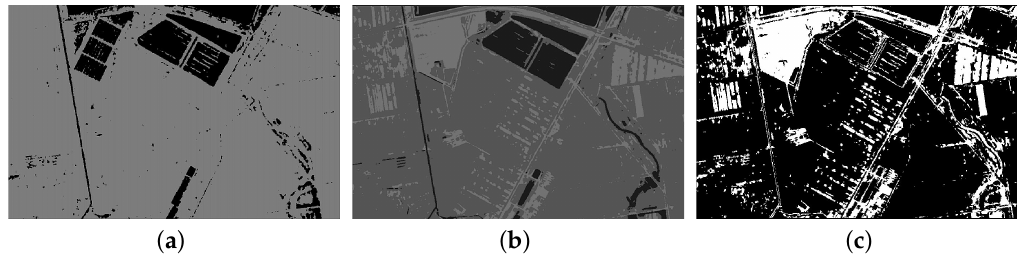
Figure 20. The overall error ( OE ) on the Shuguang Village dataset according to different numbers of pixels selected.